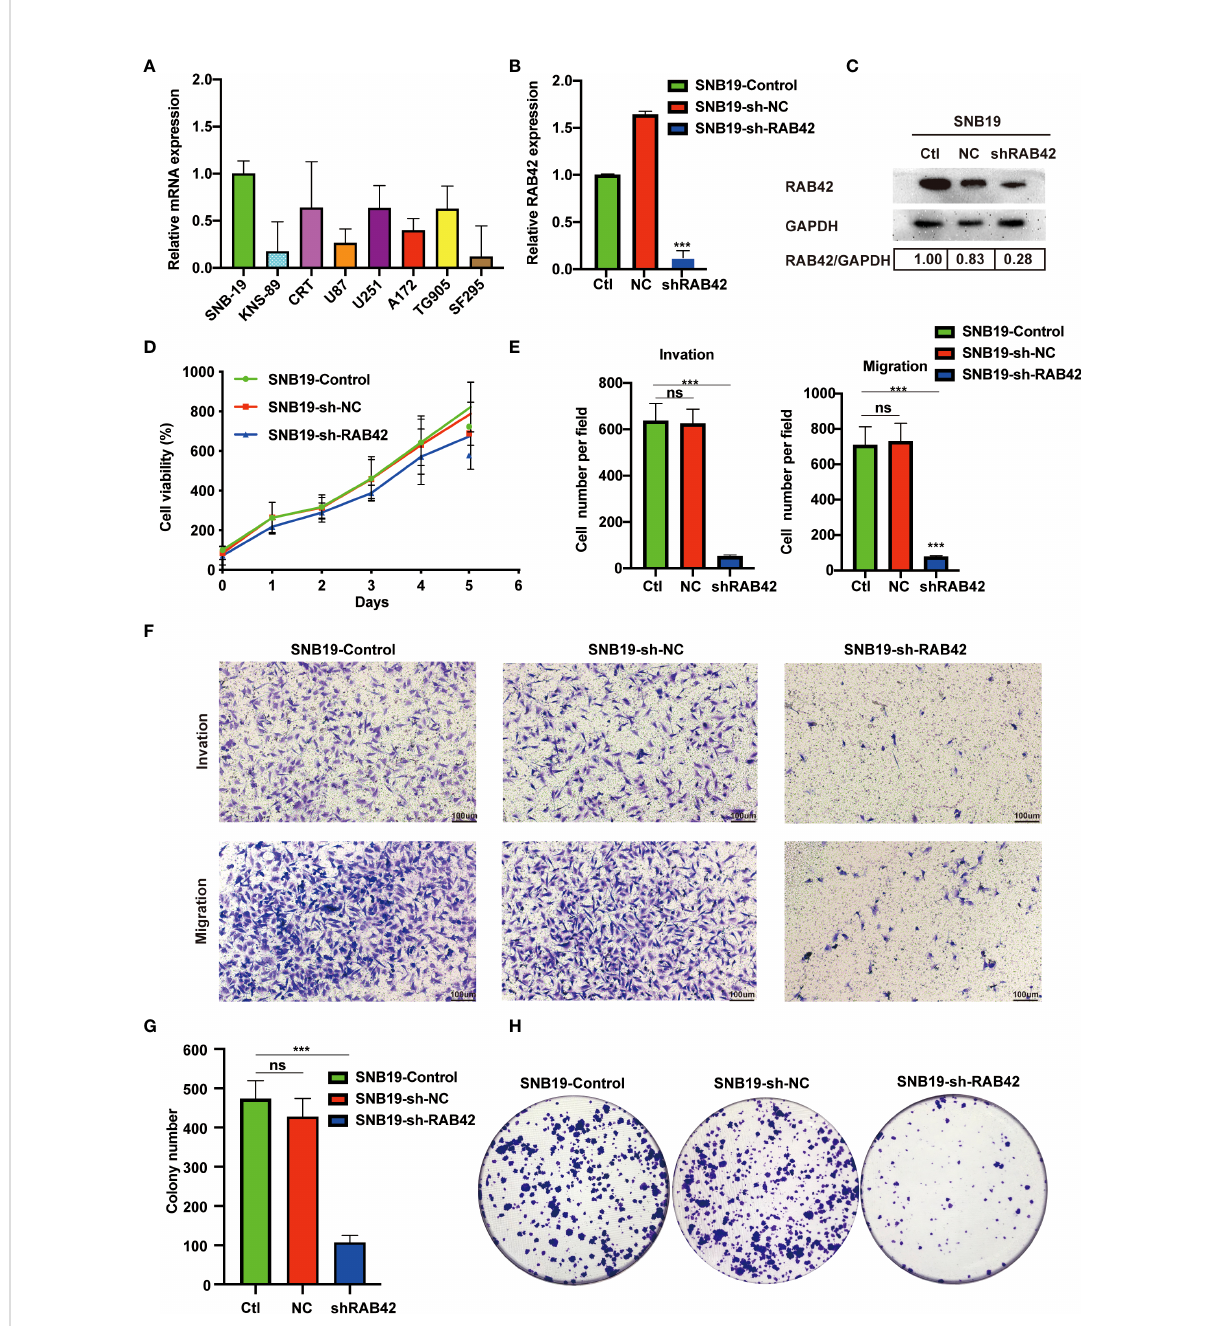
FIGURE 6 Validation of RAB42 gene functions in vitro . (A) Relative mRNA expression of SNB-19, KNS-89, CRT, U87, U251, A172, TG905 and SF295. (B) Relative expression of RAB42 in SNB19 cell lines after RAB42 knockdown (SNB19-sh- RAB42 ), parental cell line SNB19 (SNB19- Control) and control corresponding to the parental cell line transfected with the empty expression vector (SNB19-sh-NC). (C) Relative protein expression of SNB19-sh- RAB42 , SNB19-Control and SNB19-sh-NC. (D) Cellular viability by CCK8 assay. (E) Quanti fi cation of invasion and migration assays. (F) Transwell invasion and migration assays. (G) Quanti fi cation of colony number in clonogenic assay. (H) Clonogenic assays. “ ns ” means “ not signi fi cant ” , *** means P <